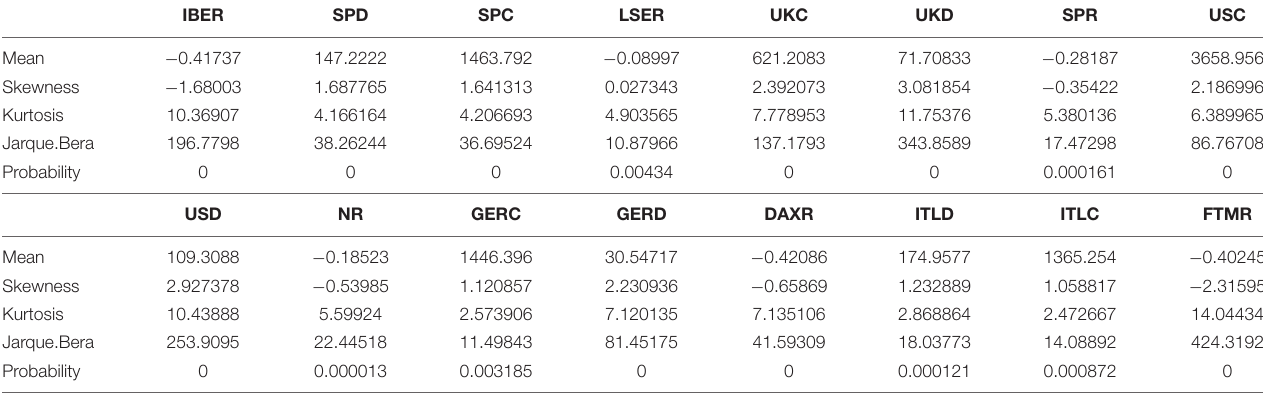
TABLE 1 | Descriptive statistics.